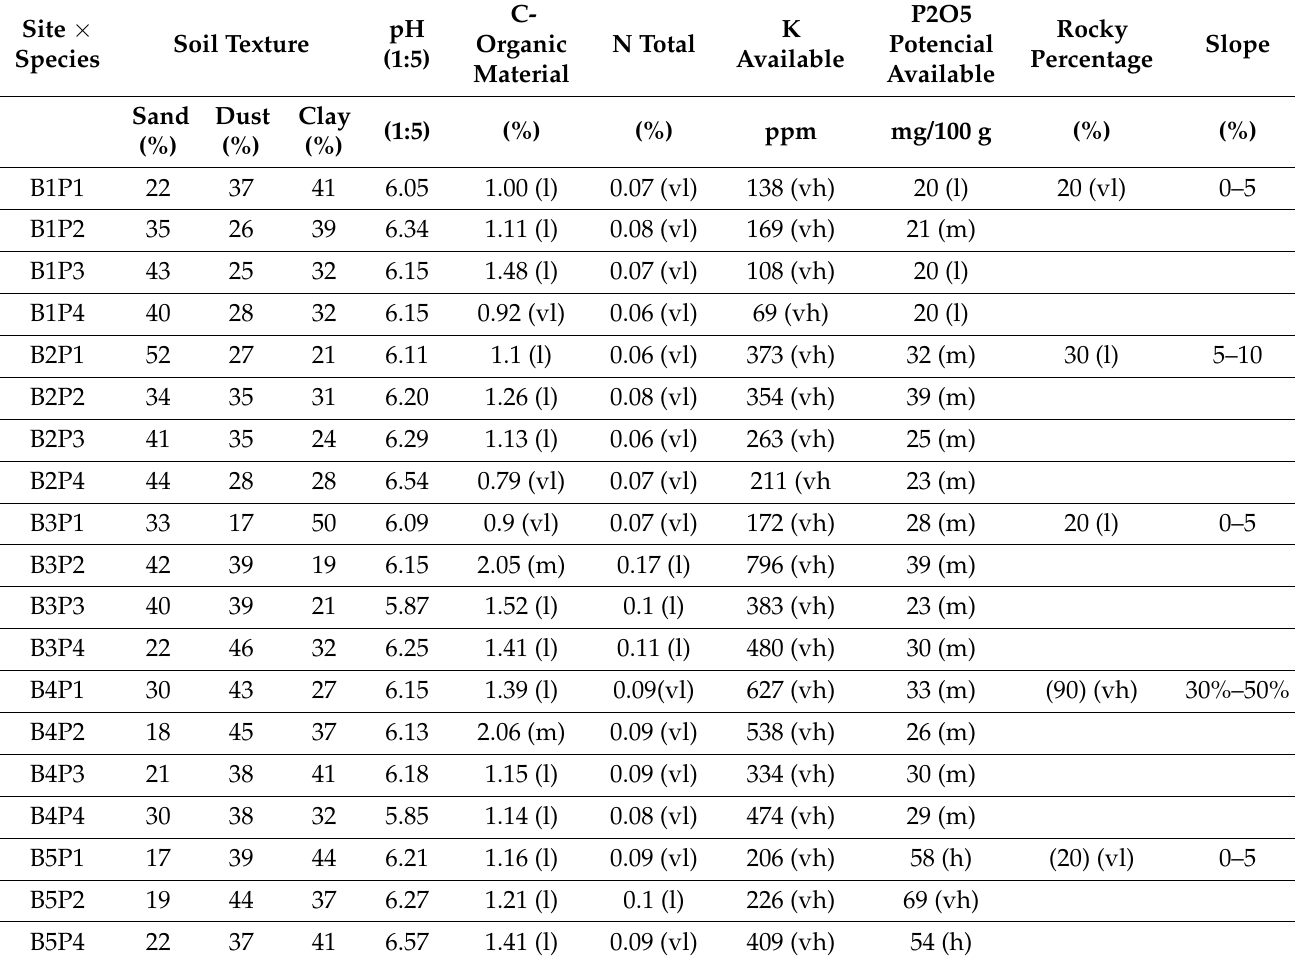
Table 1. Soil characteristics of the trial site in Gunungkidul